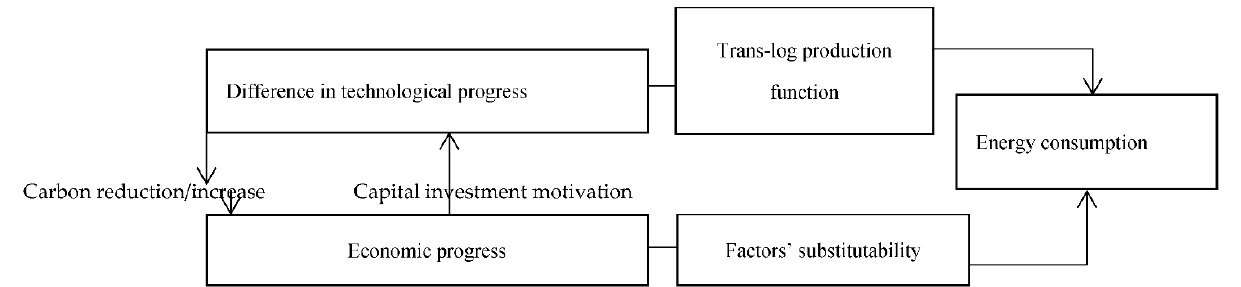
Figure 2. Logical framework of this study.